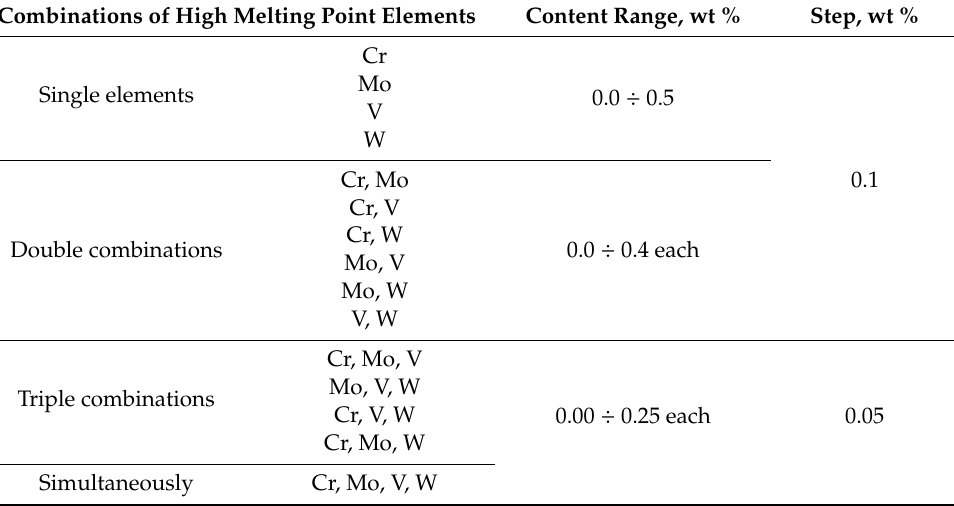
Table 2. Content of high melting point elements in the tested